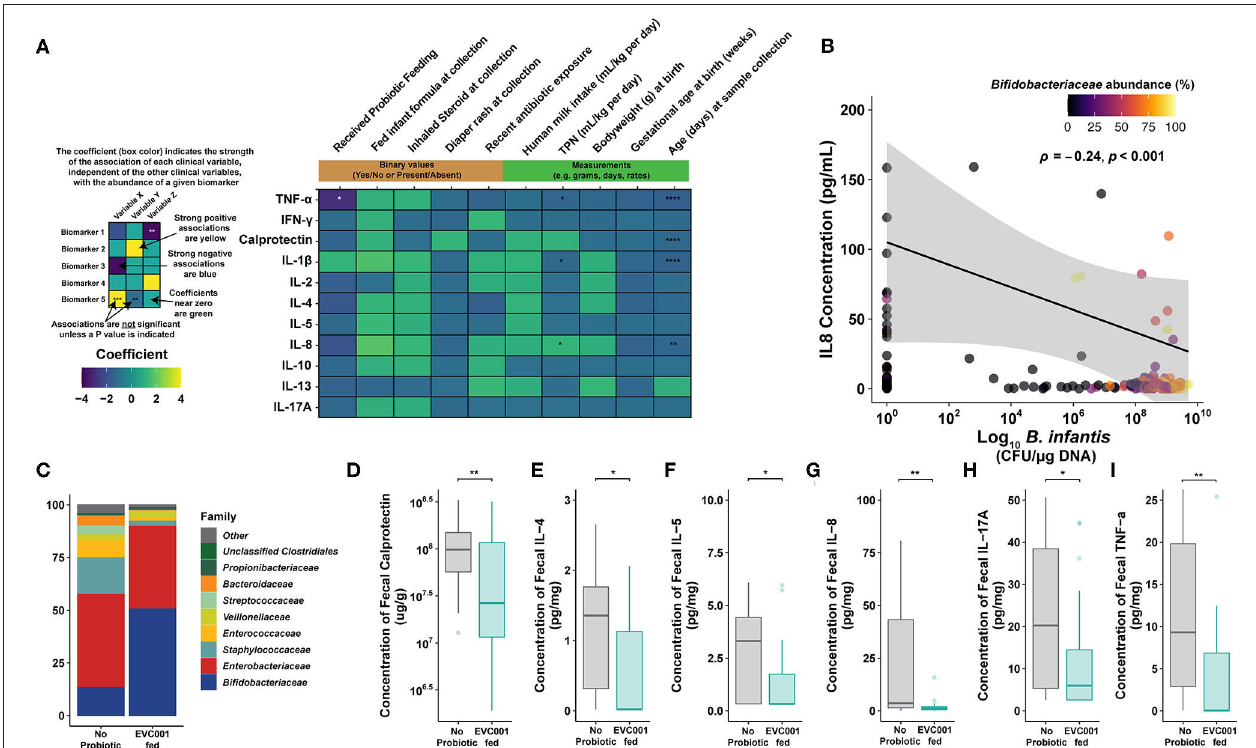
FIGURE 6 | Proinflammatory biomarkers are significantly lower in preterm infants fed B. infantis EVC001. (A) Multivariate analysis by linear models (MaAsLin2) was used to assess the effect that each clinical variable had, independently, on proinflammatory biomarker concentrations. Probiotic feeding ( B. infantis EVC001) was significantly associated with lower TNF α concentrations (-1.06 pg/mL per kg per day; FDR-corrected P value = 0.0011). TPN (mL/kg * day) correlated with increased IL-8 production (1.25 pg/mL per unit increase; FDR-corrected P value = 0.02) and a decrease of IL-1 β and TNF α (0.064 and 0.1 pg/mL * day; FDR-corrected P value = 0.02, 0.02, respectively). Day of life at sampling associated with decreased calprotectin, IL-1 β , IL-8, and TNF α production at a rate of 0.04, 0.07, 0.1, and 0.08 pg/mL * day, respectively (FDR-corrected P value = 0.0001, 0.0001, 0.002, and 0.0001, respectively). No significant associations between inhaled steroid exposure, diaper rash and treatment, antibiotic exposure, formula feeding, human milk consumption, birth weight, or gestational age at birth were identified. (B) Significantly decreased proinflammatory cytokine, IL-8, correlated with B. infantis EVC001 absolute abundance ( P = 0.001 , ρ = − 0.24). (C) The mean relative abundance of bacterial families in samples analyzed at the ∼ 34-week time point, colored by family, is shown. Mean and standard deviations are available in Supplementary Table 7 . (D–I) Box plots represent fecal calprotectin [ug/g] and proinflammatory cytokine concentrations [pg/mg] from infants not fed B. infantis EVC001 ( n = 28) and EVC001-fed infants ( n = 29) at 34 weeks corrected gestational age. Calprotectin and cytokine concentrations were measured in duplicate using MesoScale Discoveries R and U-plex, respectively. Statistical analysis was completed using Wilcoxon rank-sum test. P- values were adjusted using the FDR